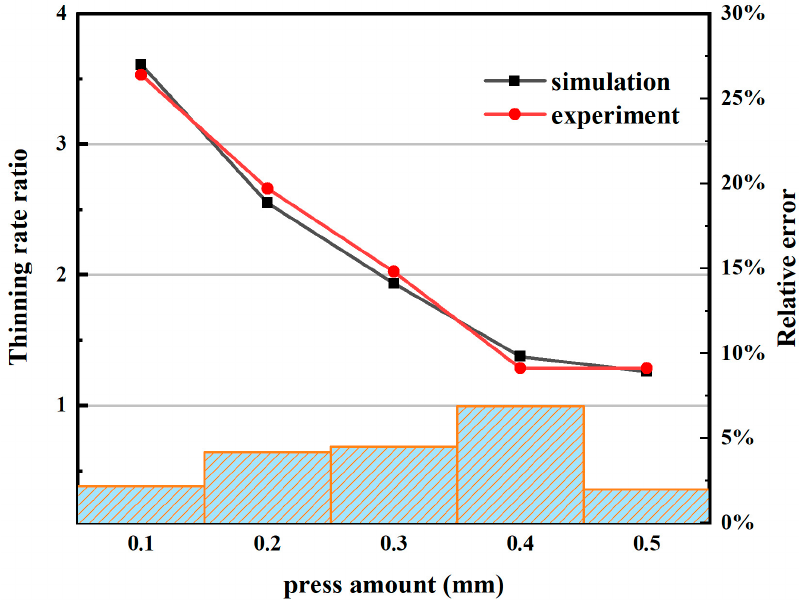
Figure 6. Ratio of thinning rate of cover and basic tubes after rotary ring spinning.